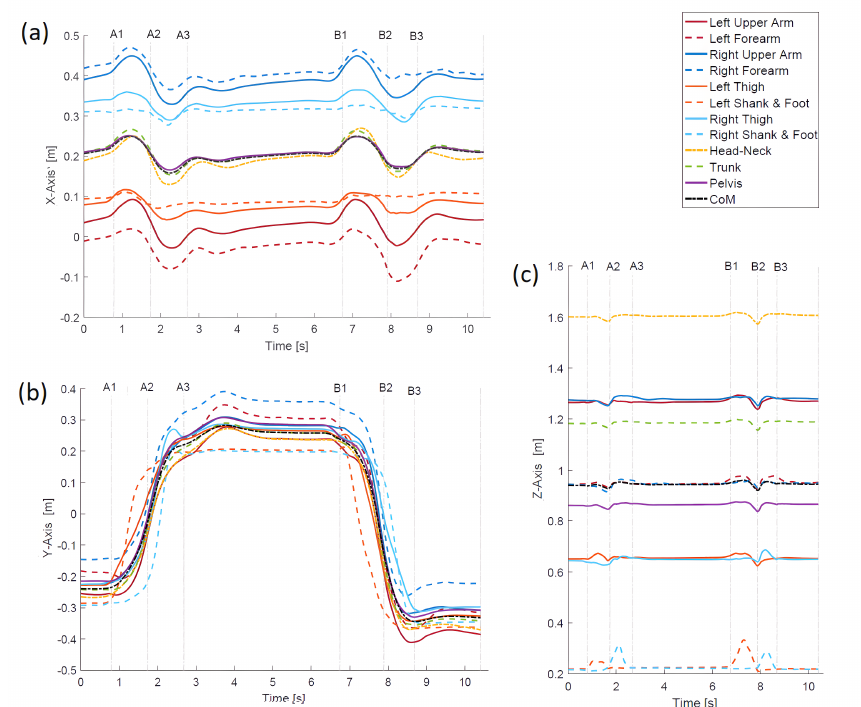
Figure 6. Displacement trajectories during stepping. ( a ) trajectories along the X-axis; ( b ) trajectories along the Y-axis; ( c ) trajectories along the